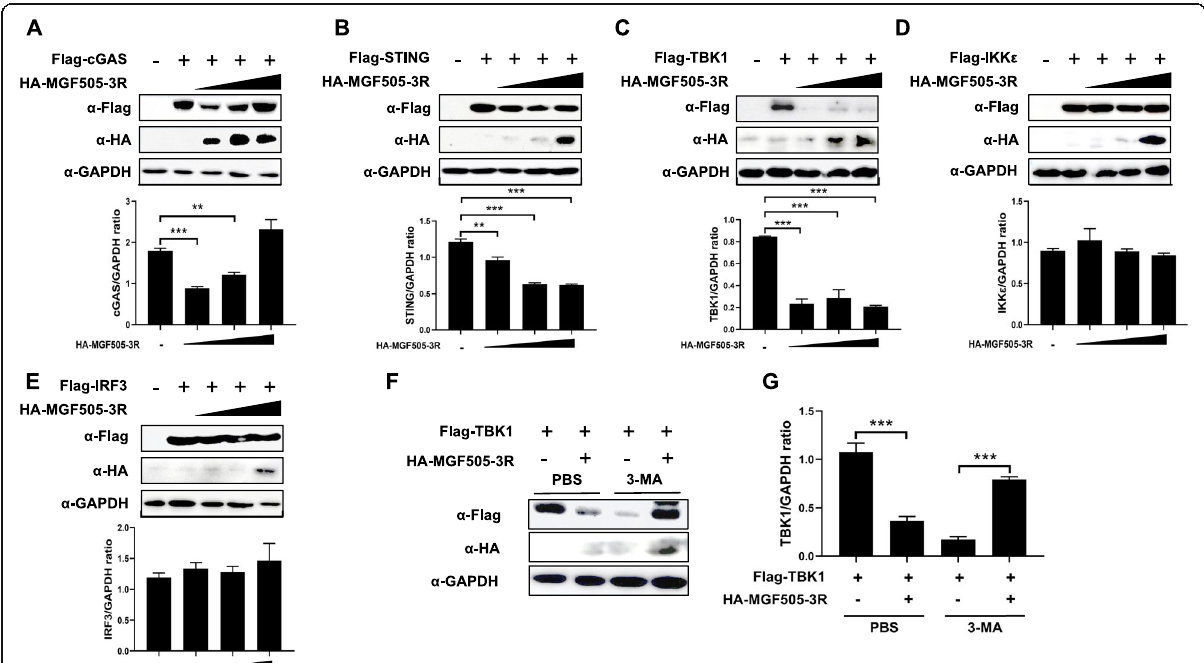
Fig. 5 Inhibition of MGF505-3R-mediated TBK1 degradation. A-E Signaling molecule plasmids (Flag-cGAS, Flag-STING, Flag-TBK1, Flag-IKK ε , Flag- IRF3) (200 ng) were cotransfected into HEK293T cells with increasing doses of HA-MGF505-3R (50 ng, 100 ng, 200 ng), and the cells were collected after 24 h. F-H HA-MGF505-3R plasmid (200 ng) and TBK1 plasmid (200 ng) were cotransfected into HEK293T cells for 24 h. 3-MA (10 mM) was added 6 h before sample collection. All samples were analyzed by Western blotting with the indicated antibodies and quantitative analysis of protein blots using ImageJ software. All data from 3 independent experiments are expressed as the mean ± SD. * P <0.05, ** P <0.01, *** P